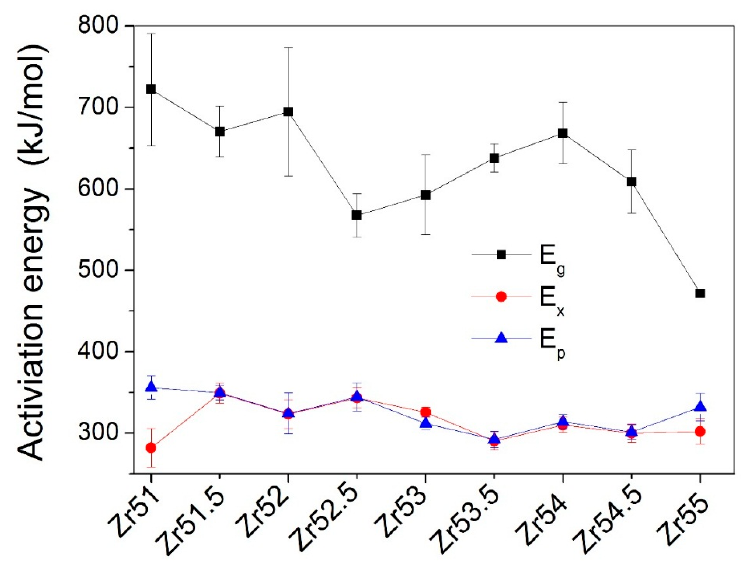
Figure 7. Dependences of the activation energies ( E g , E x , and E p ) on the Zr content.